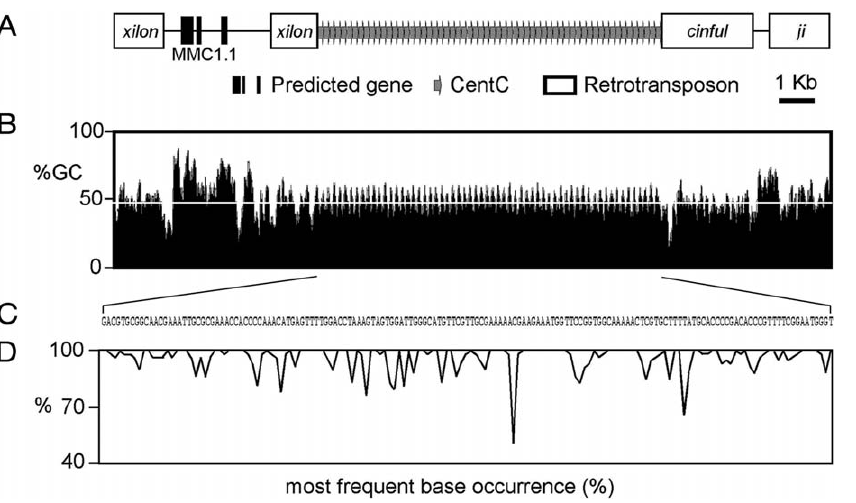
Figure 3. Sequence Analysis of the MMC1 Centromeric Fragment (A) Assembled sequence. (B) Fifty base-pair sliding window analysis of MMC1 GC content; white line, genomic average ¼ 49.5%. (C) Consensus sequence of ; 60 MMC1 CentC repeats. (D) The occurrence of the most frequent base (%) for each nucleotide in the CentC consensus.